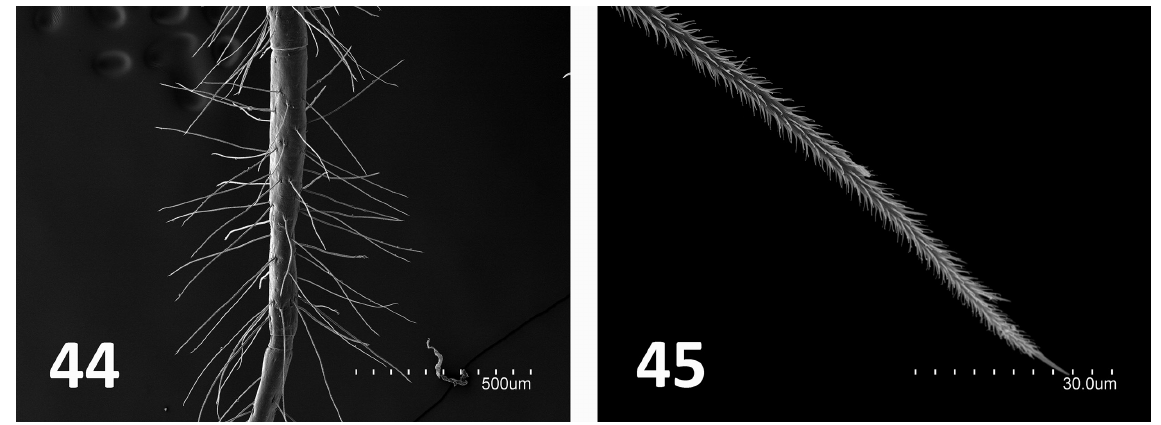
Figs 44‒45. Hubeicampa melissa Sendra & Lips gen. et sp. nov. 44 . Central cercal articles. 45 . Detail of a cercal macroseta.